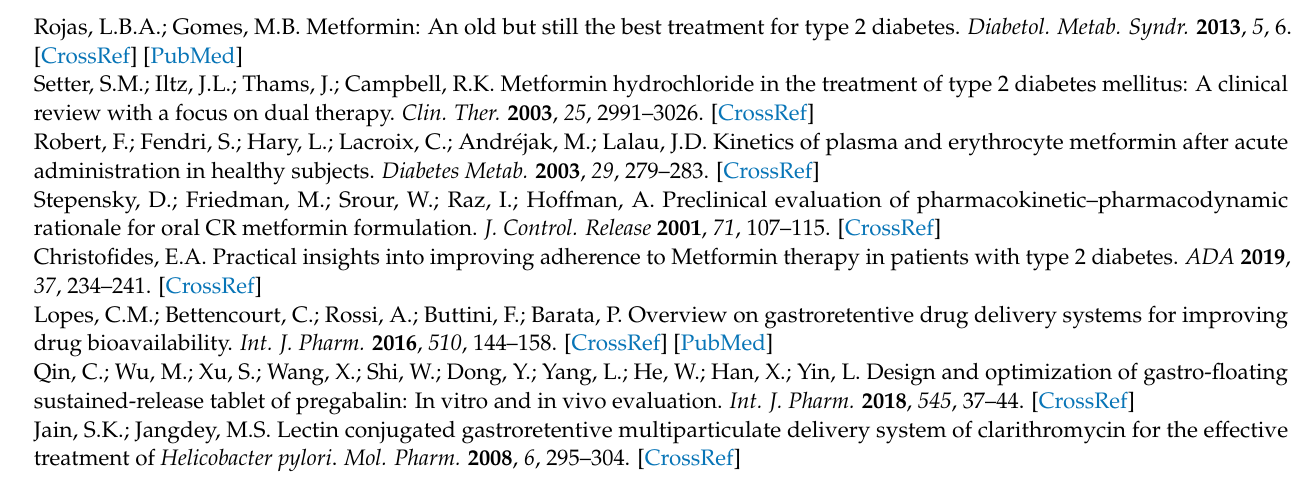
Table S4: Comparison of the dissolution profiles for the optimized formulations predicted using the RSM with the experimentally obtained dissolution profiles. Figure S1: PXRD patterns for crystalline metformin HCl, spray-dried solid dispersions, and Glucophage XR. Figure S2: Images of non-EFTs in the vessels after the 24-h dissolution test ( n = 12). Figure S3: Images of non-EFTs during (a) swelling and (b) erosion tests over time. Non-EFTs were taken out from the vessels at predetermined times during the dissolution